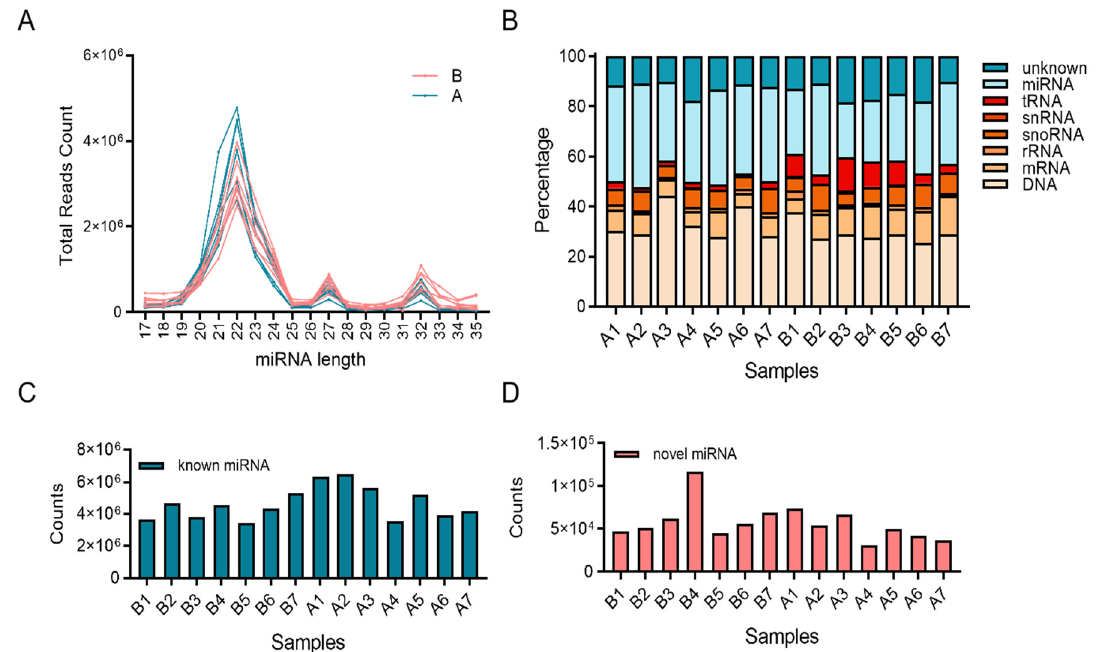
Figure 1. Summary of the small RNAs (sRNAs) sequencing data and the distribution of sRNAs. ( A ) Length distribution of sRNAs between before and after transportation. ( B ) Annotation distribution of sRNAs between before and after transportation. ( C ) Known miRNA reads statistics in 14 samples. ( D ) Novel miRNA reads statistics in 14 samples.